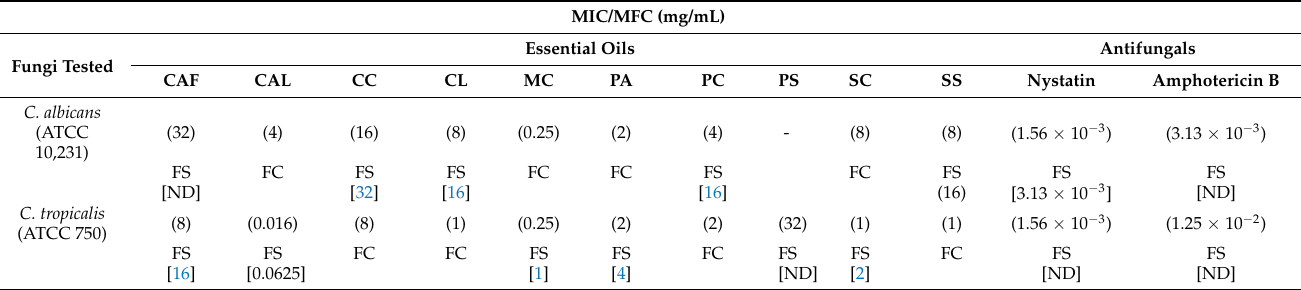
Table 2. Antifungal activities of EOs against Candida spp. MIC/MFC